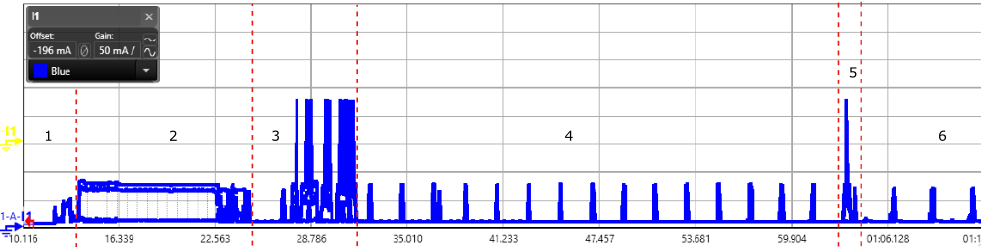
Figure 19. Scope view of a NB-IoT data transmission captured using power analyzer showing all the states.